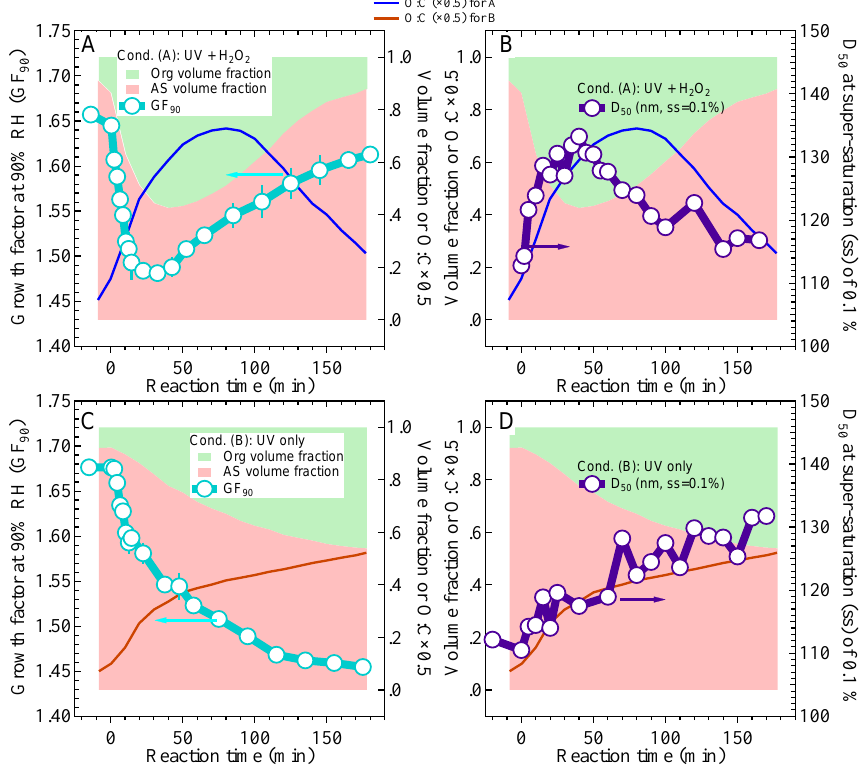
Fig. 7. HTDMA measured growth factor at 90% RH (GF 90 ) (panels a and c ) and CCNc-measured D 50 at super-saturation (ss) of 0.1% Figure 7. HTDMA measured growth factor at 90% RH (GF 90 ) (panels A and C) and CCNc measured 2 (panels b and d ) under condition (A) (panels a and b ) and condition (B) (panels c and d ). Also shown are volume fractions of organics and D 50 at super-saturation (ss) of 0.1% (panels B and D) under condition (A) (panels A and B) and 3 ammonium sulfate, as well as O:C condition (B) (panels C and D). Also shown are volume fractions of organics and ammonium sulfate, 4 as well as O:C ratios. 5